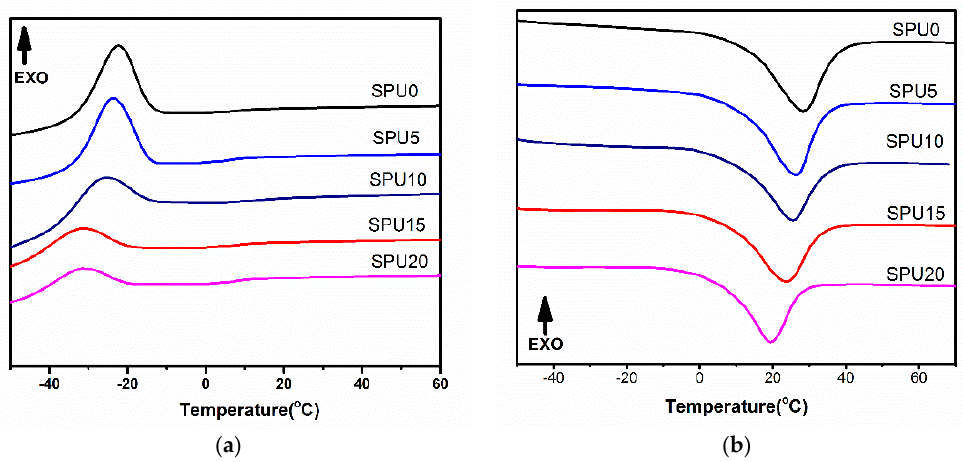
Figure 8. DSC thermograms of SPU films with different HDI-T contents: ( a ) curves of the cooling process; and ( b ) curves of the second heating process. Table 2. Crystallization temperature and melting temperature of different SPU films.